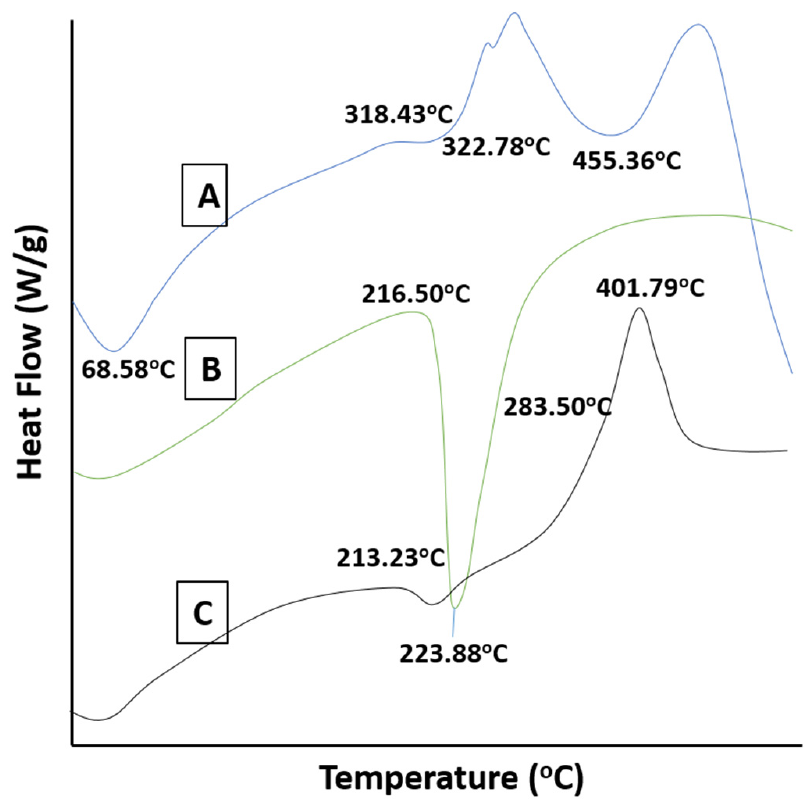
Figure 5. DSC thermograms of HP β CD ( A ), cytarabine ( B ) and cytarabine-loaded hydrogels ( C ).